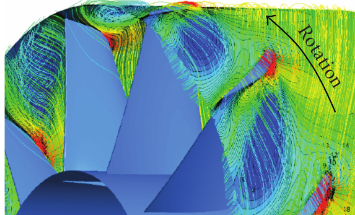
Figure 6: Flow scenario with leakage flow, UNS rotor τ/ ch = 2 .